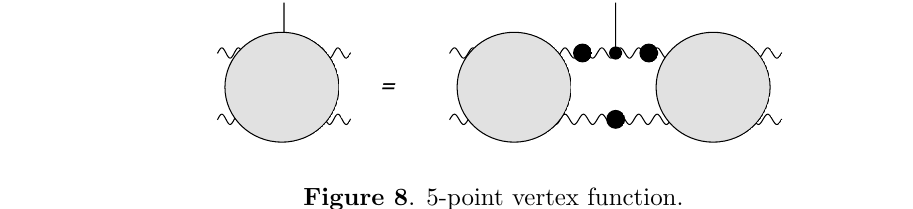
Figure 8 . 5-point vertex function.